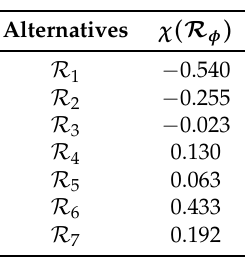
Table 12. Net flow of